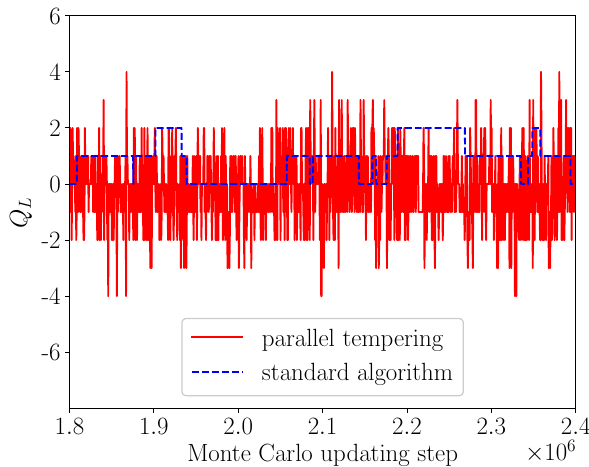
Figure 1 . Monte Carlo time evolution of the lattice topological charge Q L for a run with N = 6, β = 25 . 75 and θ L = 0. For the comparison to be fair, data for the parallel tempering case are plotted as a function of the total number of global updates performed on all the replicas, i.e. 17 times the number of parallel tempering